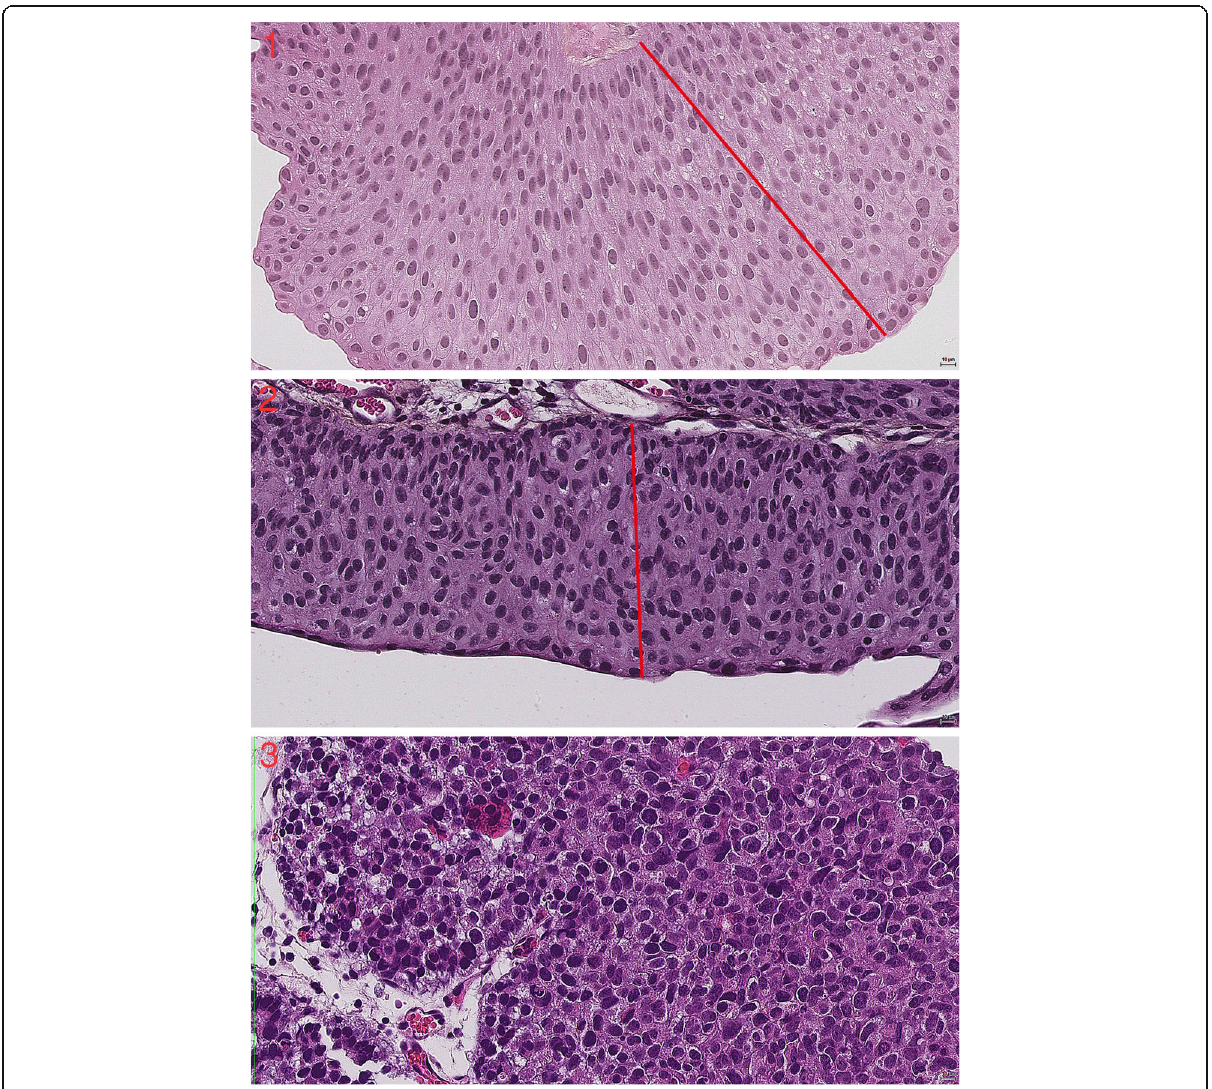
Fig. 1 The images 1 – 3 show decreasing nuclear polarity at 40 x magnification. The red line is for comparison with the axis of the